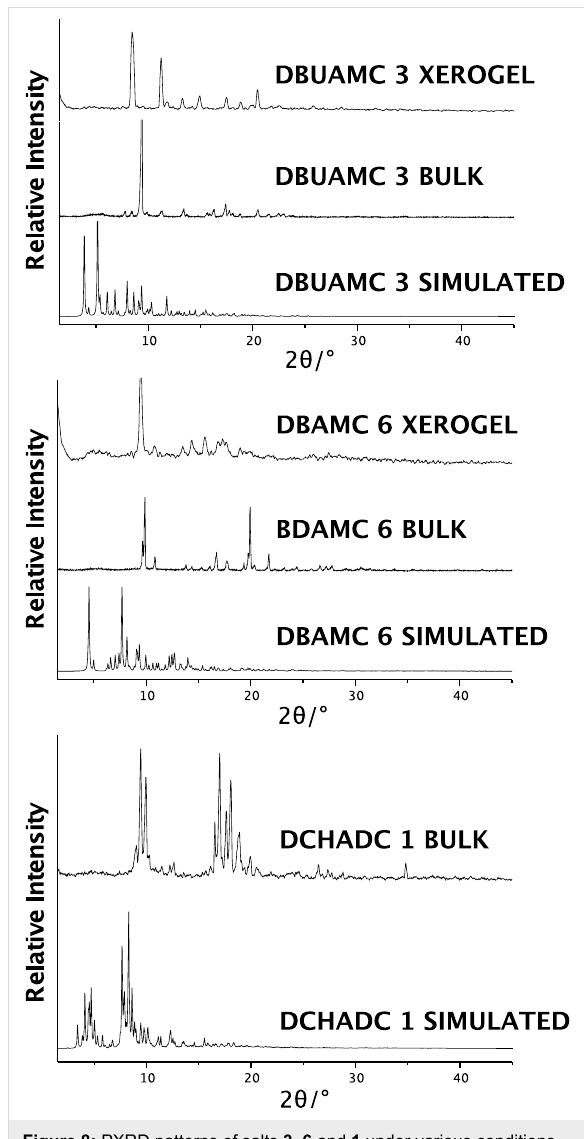
Figure 8: PXRD patterns of salts 3 , 6 and 1 under various